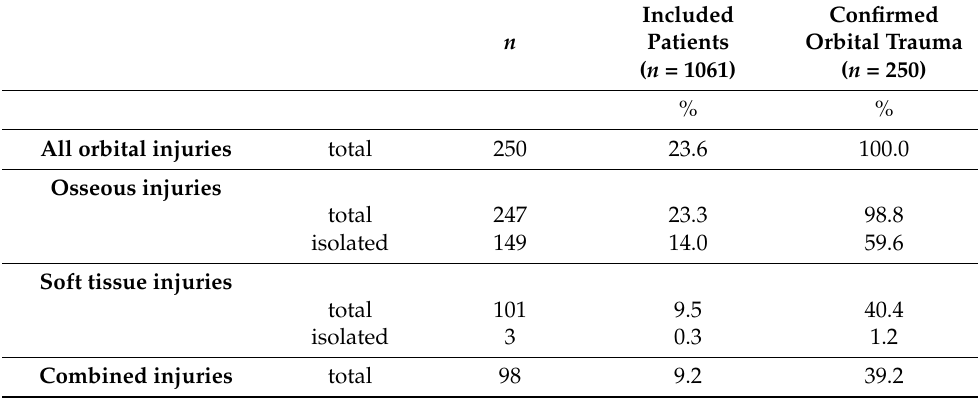
Confirmed Included n Orbital Trauma Patients ( n = 250) ( n = 1061) % %